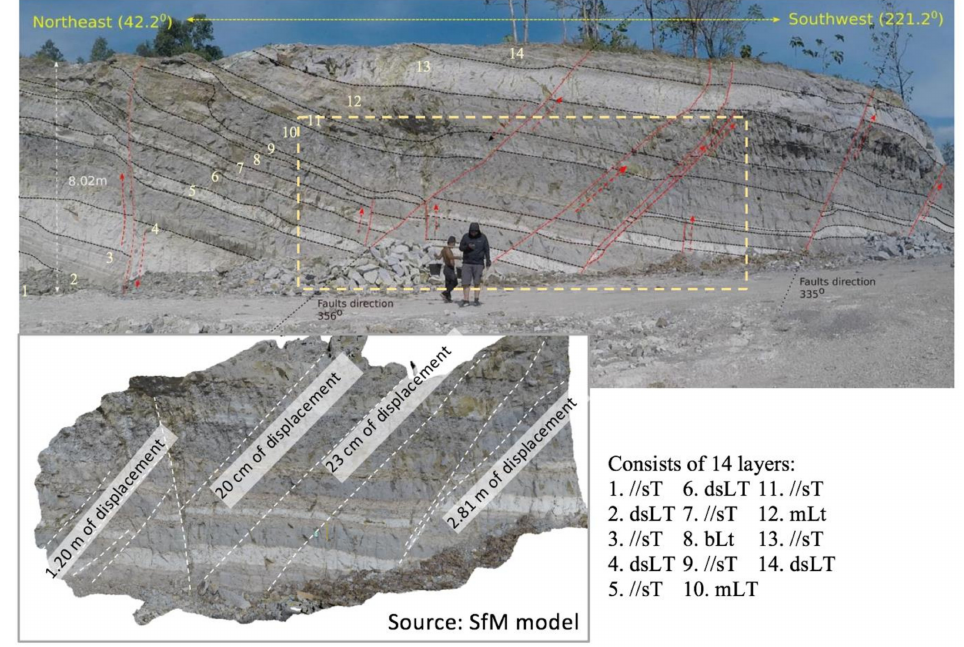
Figure 18. The outcrop